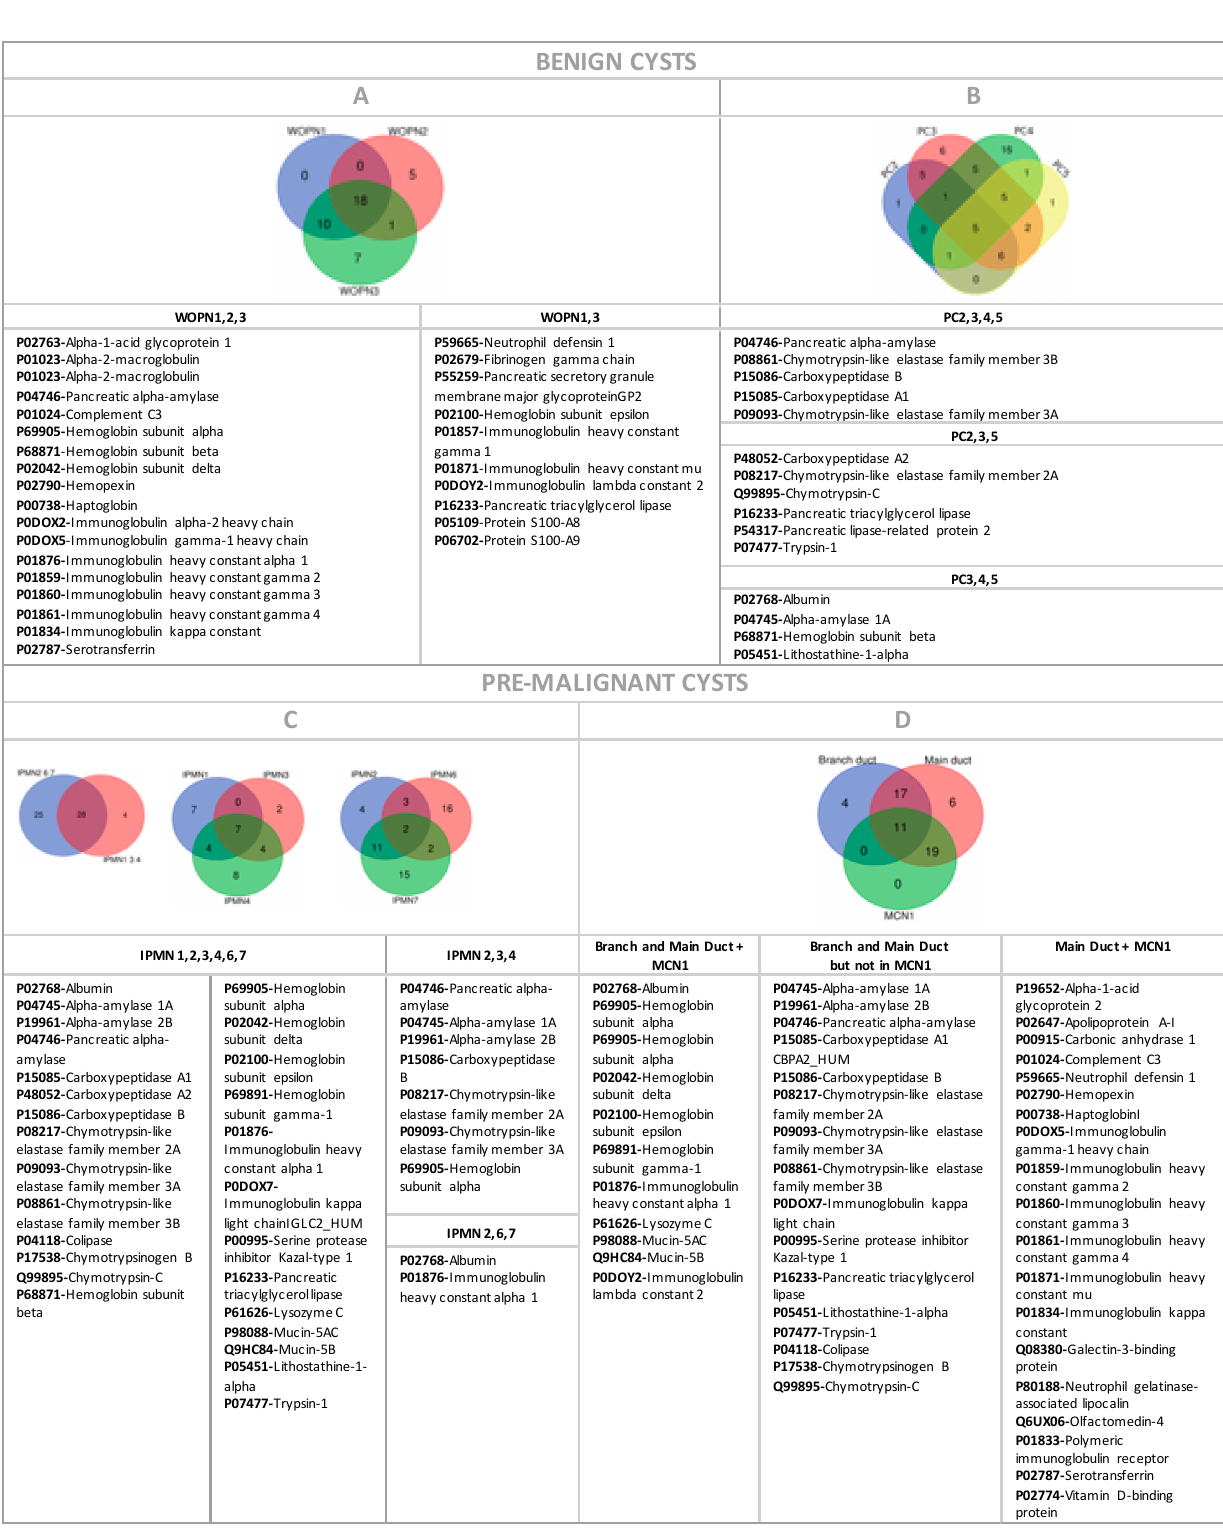
Figure 4. LC-ESI-MS/MS proteomic content of cystic samples according to cystic types: ( A ) WOPN, ( B ) PC, ( C ) IPMN, and ( D ) MCN+IPMN. Common proteins were analyzed via Venn diagrams online tool. Colors code for different groups and numbers inside each set and shared sub-sets indicate the number of identified proteins.